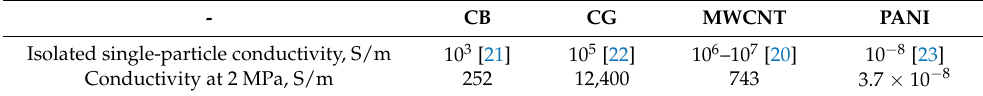
Table 2. The conductivities of the four conductive additives.